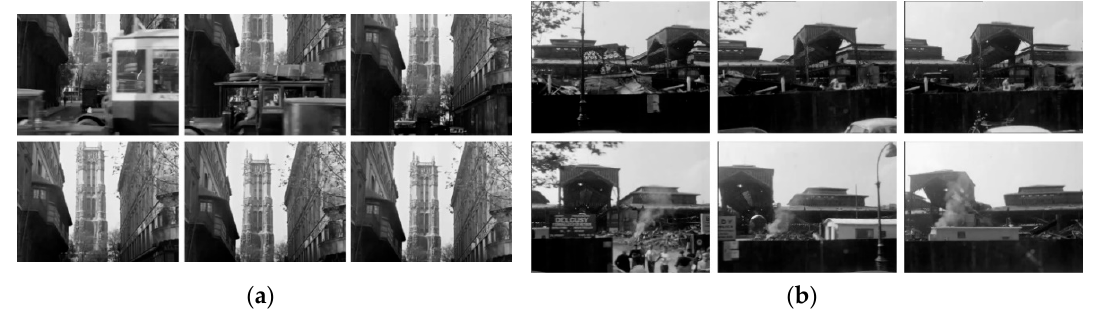
Figure 24. A selection of frames from the film footage: ( a ) “Études sur Paris”; ( b ) “La Destruction des Halles de Paris”. Table 7. Technical features of the films used during the photogrammetric processing.